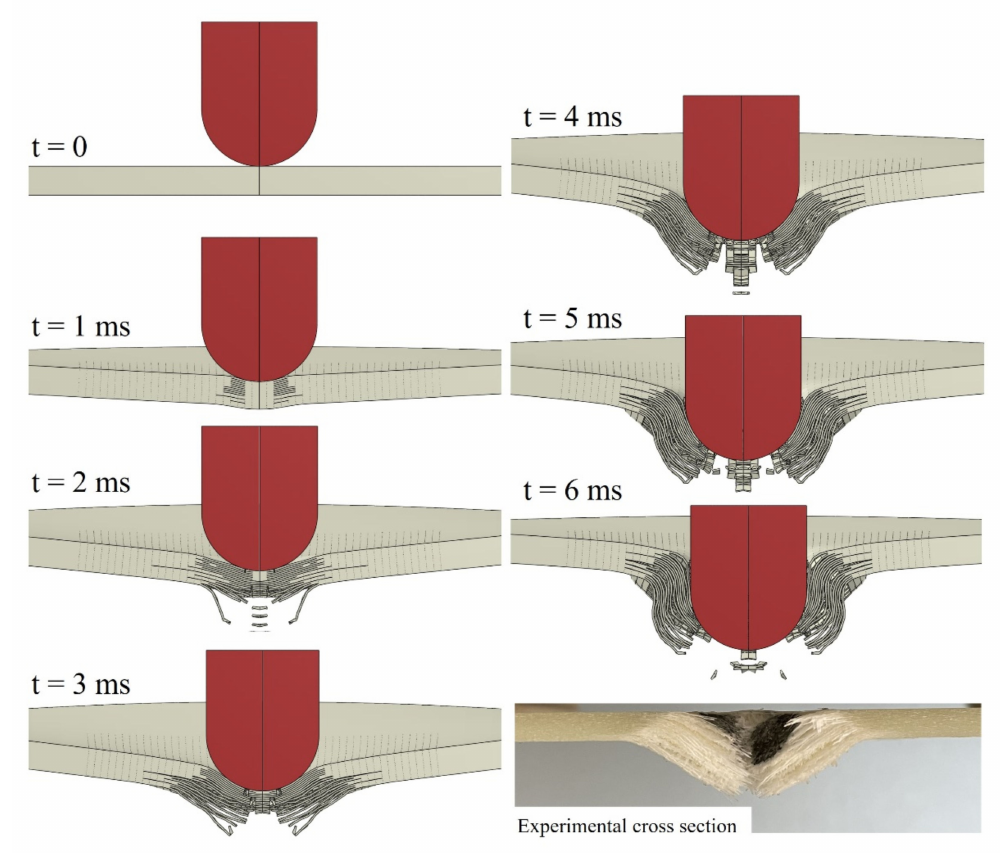
Figure 12. Contour plots of damage morphology at different simulation times for the CD model in comparison to the experimental post-impact cross-section of the